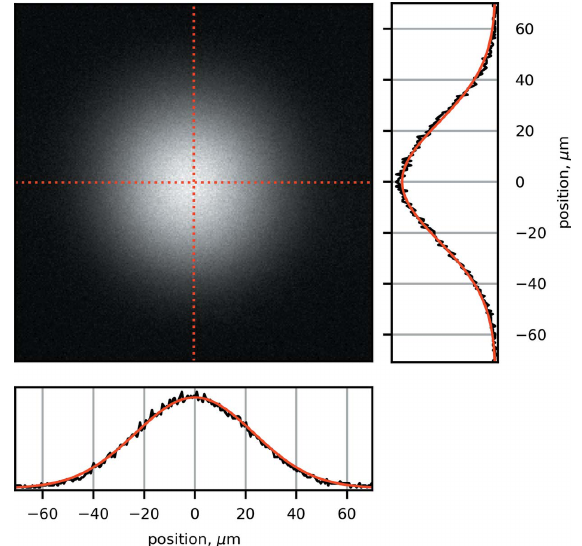
Figure 4 Beam profile produced by a polycapillary lens optic installed at the ISS beamline at 12 keV. The cuts through the profile image are shown in red while the right and bottom panels show the corresponding intensity distributions along with Gaussian fits in black and red, respectively. The FWHM of the beam is 55 m m vertically and